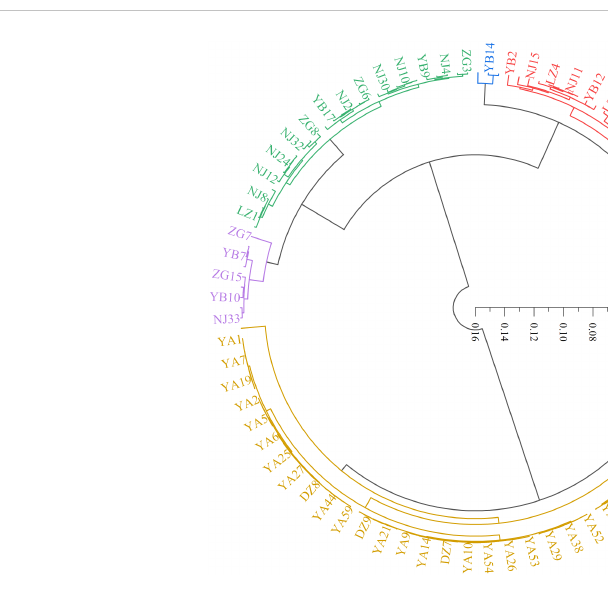
FIGURE 7 Cluster map of 143 C . oleifera germplasm